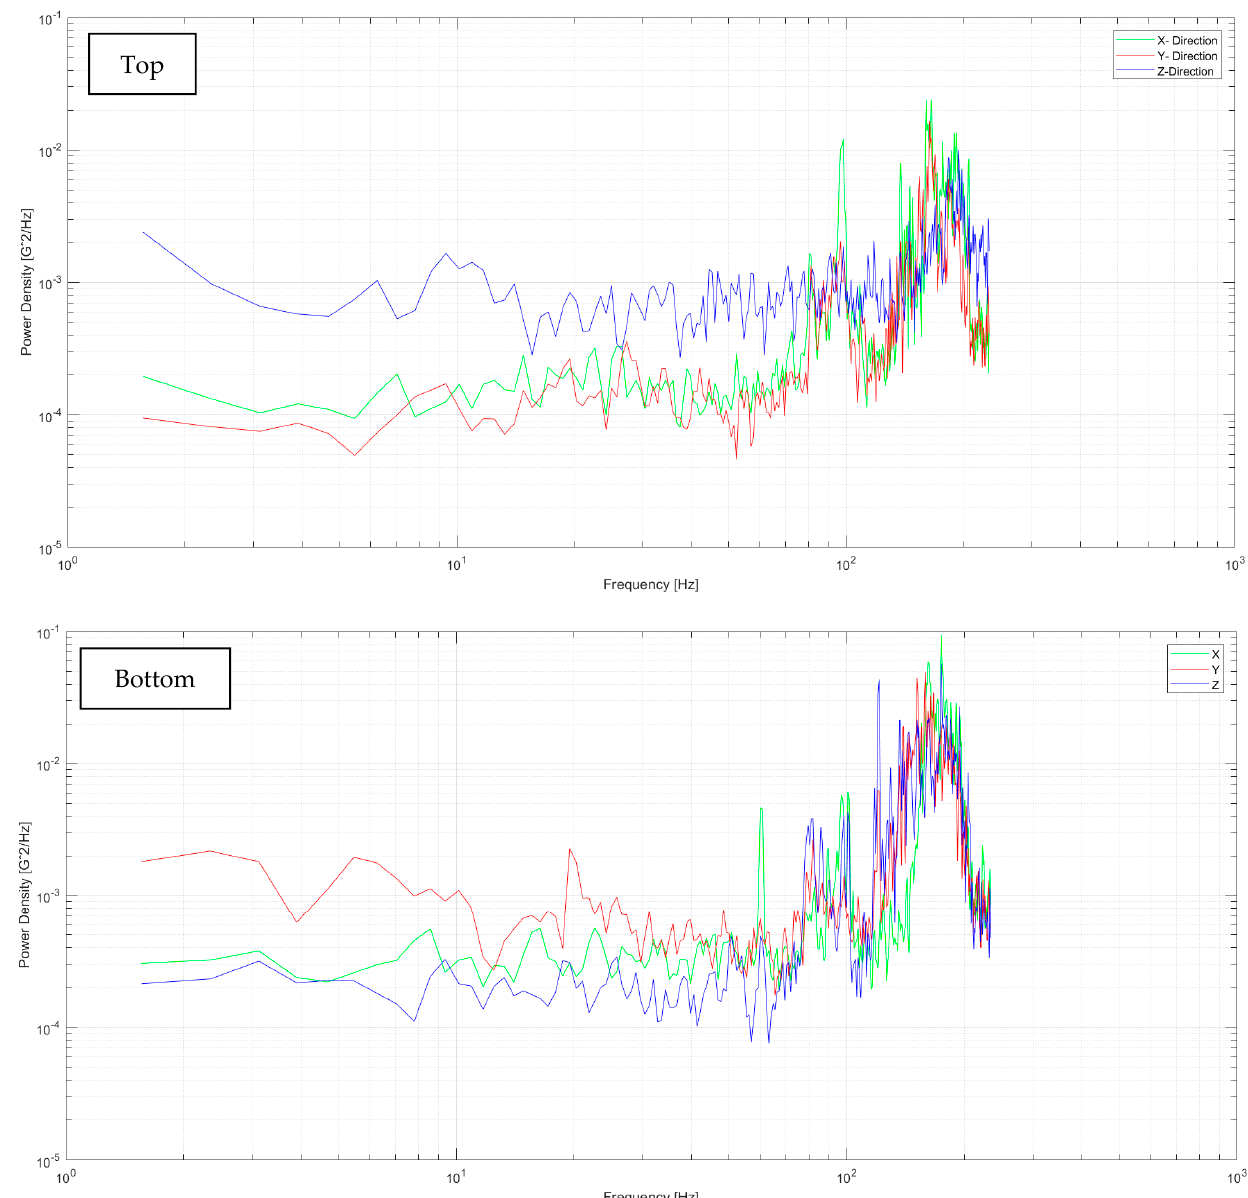
Figure 7. The consolidated PSD air profiles of the top and bottom part of the DJI Matrice 100.